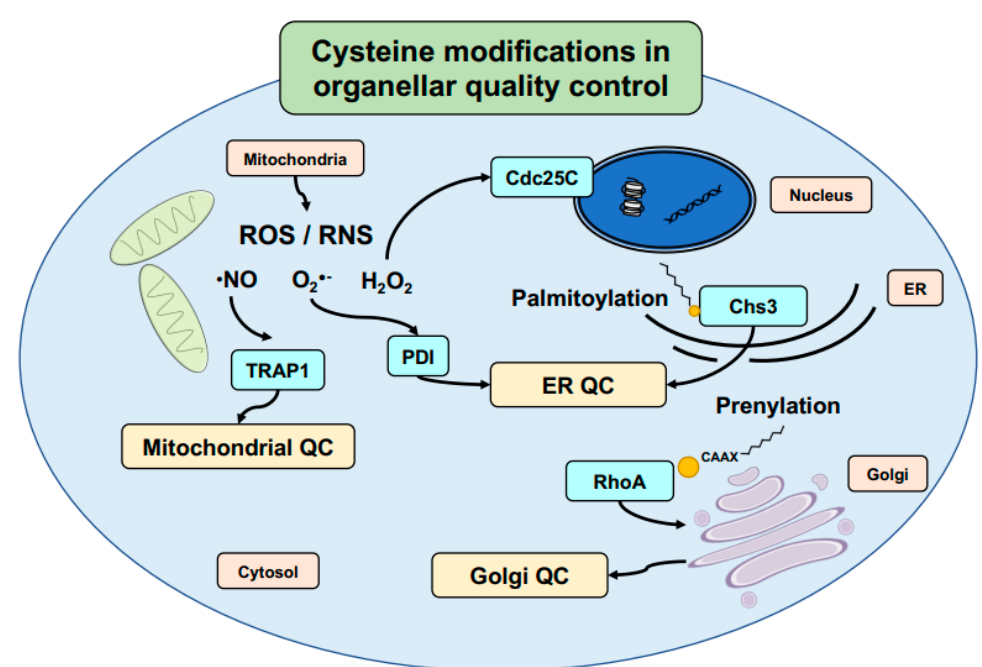
Figure 3. Thiol-modifications define protein folding and translocation. Thiol modifications come in many forms, ranging from reactive oxygen/nitrogen species (ROS/RNS) to lipid modifications during protein maturation. Various individual proteins have been found to have redox-regulated